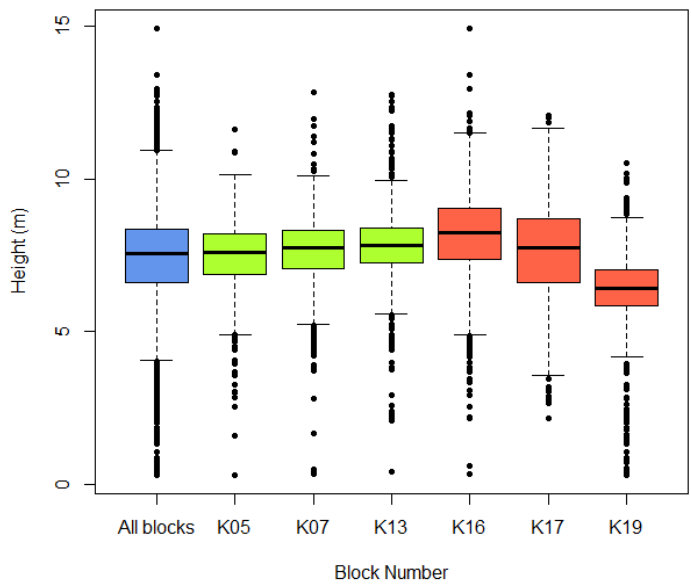
Figure 6. Boxplots for height of the blocks. The blue block shows the values for all blocks in the model farm. The healthy blocks are shown in green and the unhealthy blocks are shown in red.